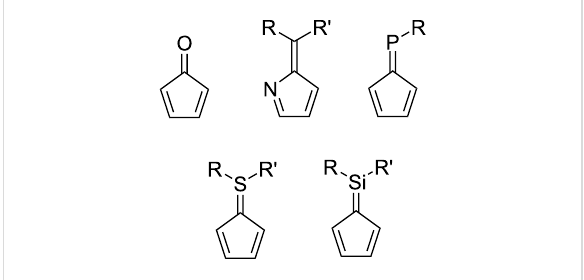
Figure 2: Generic structures of commonly referenced heteropentaful- venes, named according to the heteroatom substitution: oxafulvene, azafulvene, phosphafulvene, thiafulvene and